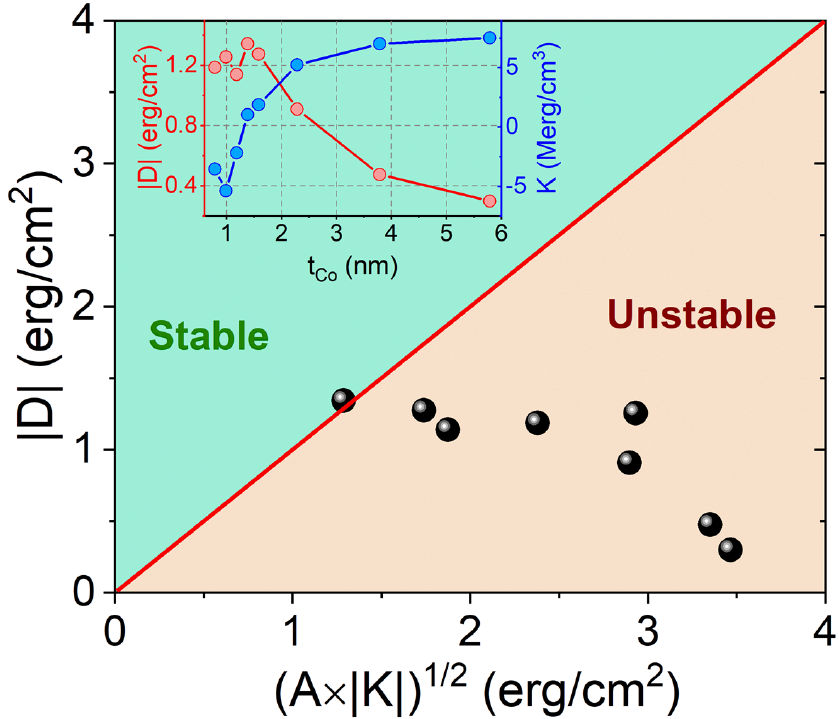
(cid:112) A | K | for Pt/Co/MgO samples with varying Co thicknesses. The Figure 1. Variation of | D | vs inset shows the Co thickness dependence of | D | and K as measured by the Brillouin light scattering technique